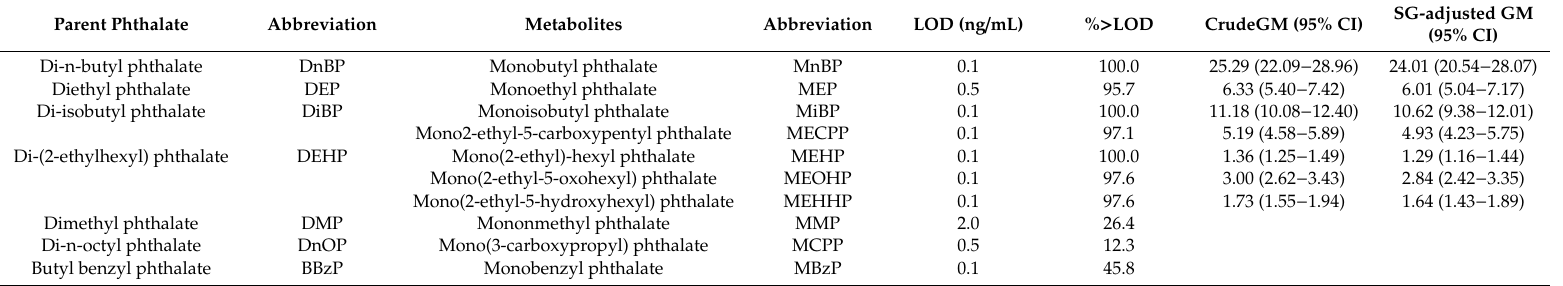
Table 2. Distribution (geometric mean [ng / mL]) of urinary phthalate metabolites among the study